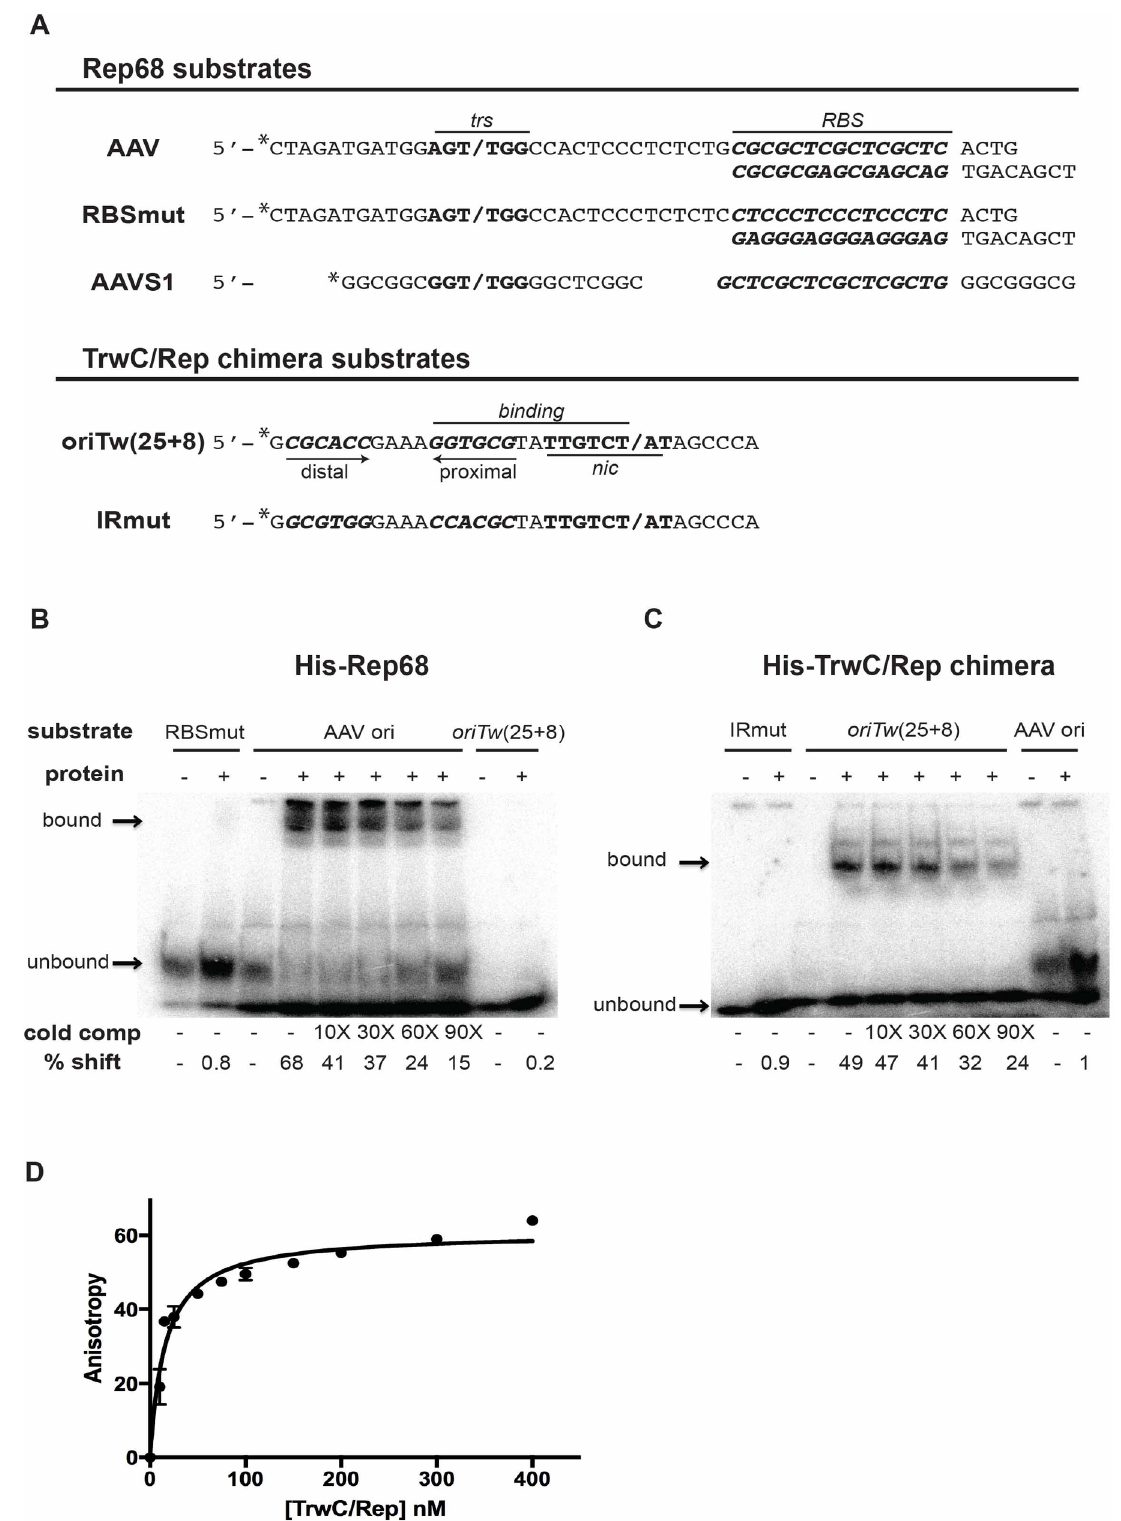
Fig 4. DNA binding activity of Rep68 and TrwC/Rep. (A) Rep68 and TrwC/Rep DNA substrates used for binding assays. Rep68 substrates were an AAV ori heteroduplex, and an equivalent AAV ori substrate mutated in the RBS sequence (RBSmut). trs is shown